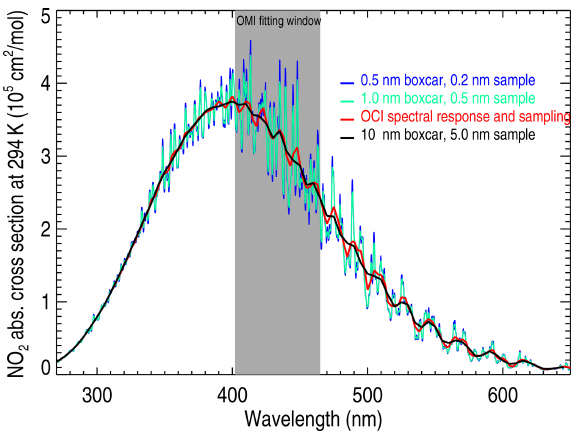
Figure 2. NO 2 cross sections from Vandaele et al. (1998) convolved with boxcar functions of different widths: blue – similar spectral characteristics to OMI (although the OMI range is limited to wave- lengths < 500nm; green – similar to OMPS-NM; red – similar to OCI; black – similar to